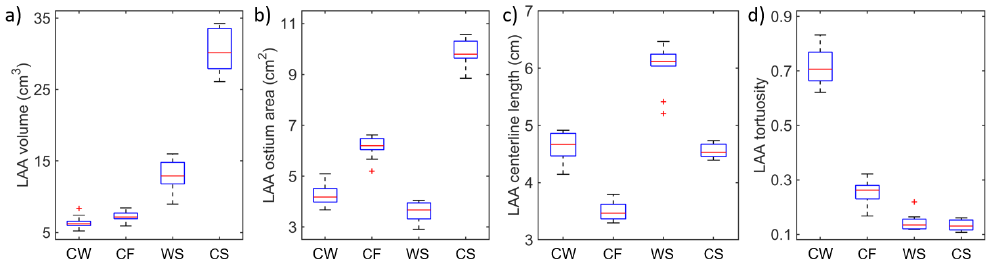
Figure 5. Boxplots of volume ( a ), ostium area ( b ), centerline length ( c ) and tortuosity ( d ) measurements of LAA morphologies over a cardiac cycle.